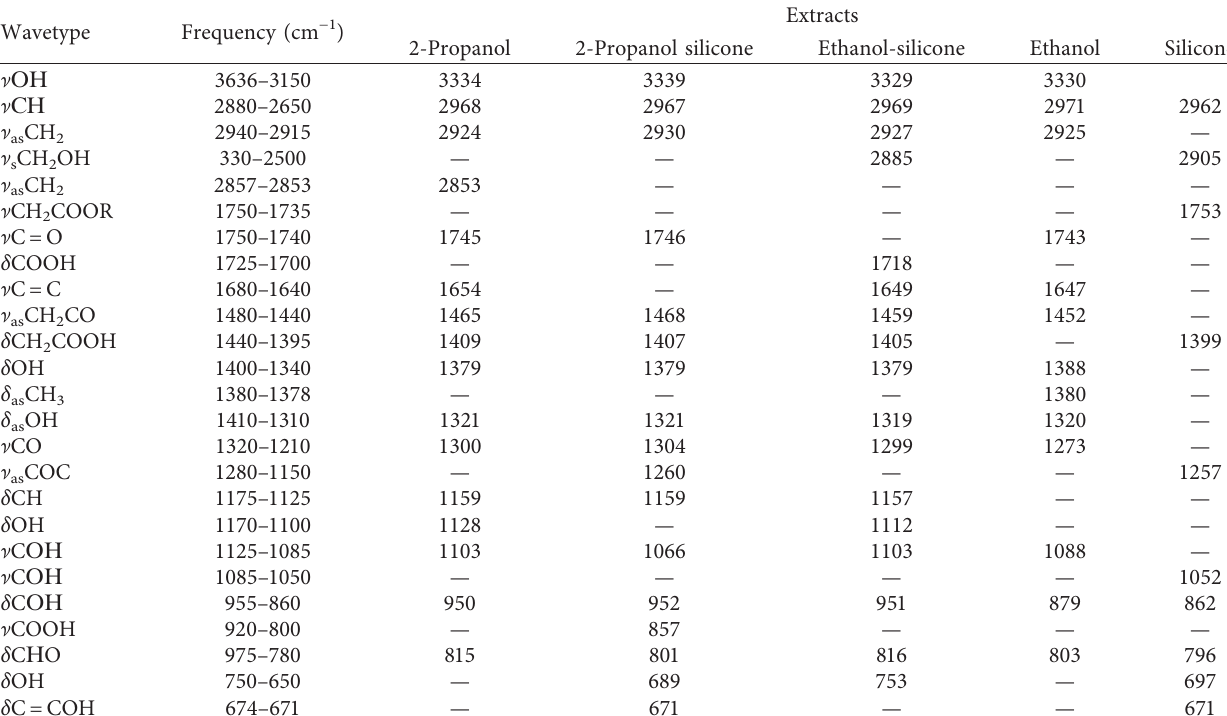
Figure 2: (a) IR spectrum of the extract of apricot cake obtained by ethanol, silicone, and ethanol-silicone; (b) IR spectrum of the extract of apricot cake obtained by 2-propanol, silicone, 2-propanol-silicone. Table 3: Absorption bands (cm − 1 ) in the IR spectrum of apricot flint